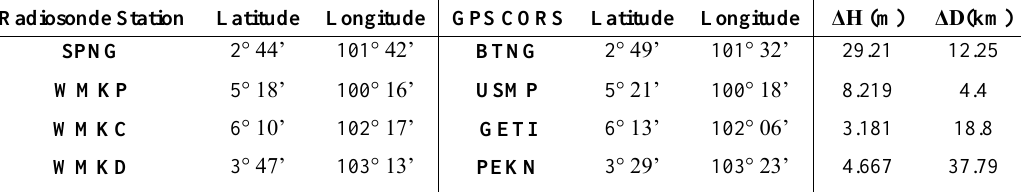
T M parameter over 23-year period observational data from 53 radiosonde stations of global radiosonde network. They found